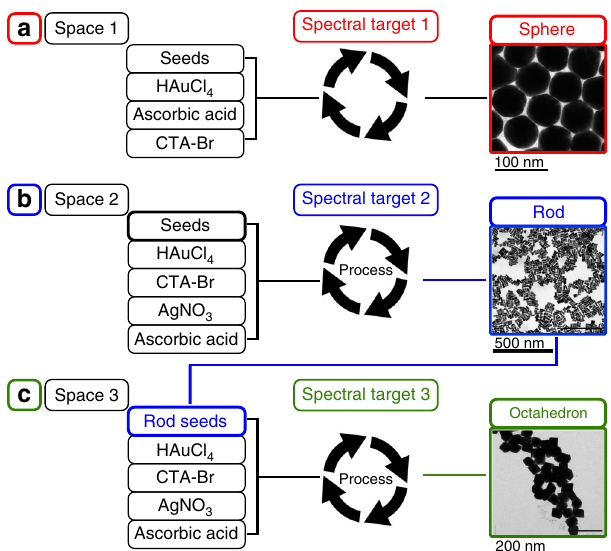
Fig. 1 Flow diagram of the hierarchical evolution of gold nanomaterials. a Chemical space 1, containing reagents for the synthesis of spheres, was explored using the platform until spectral target 1 (spheres) was reached/ optimised. b Known literature seeds 10 used in chemical space 2 with known reagents for the synthesis of rods until spectral target 2 (rods) was reached/optimised. c Target 2 optimised rods used to as seeds to achieve target 3 spectra for unknown nanoparticle shape